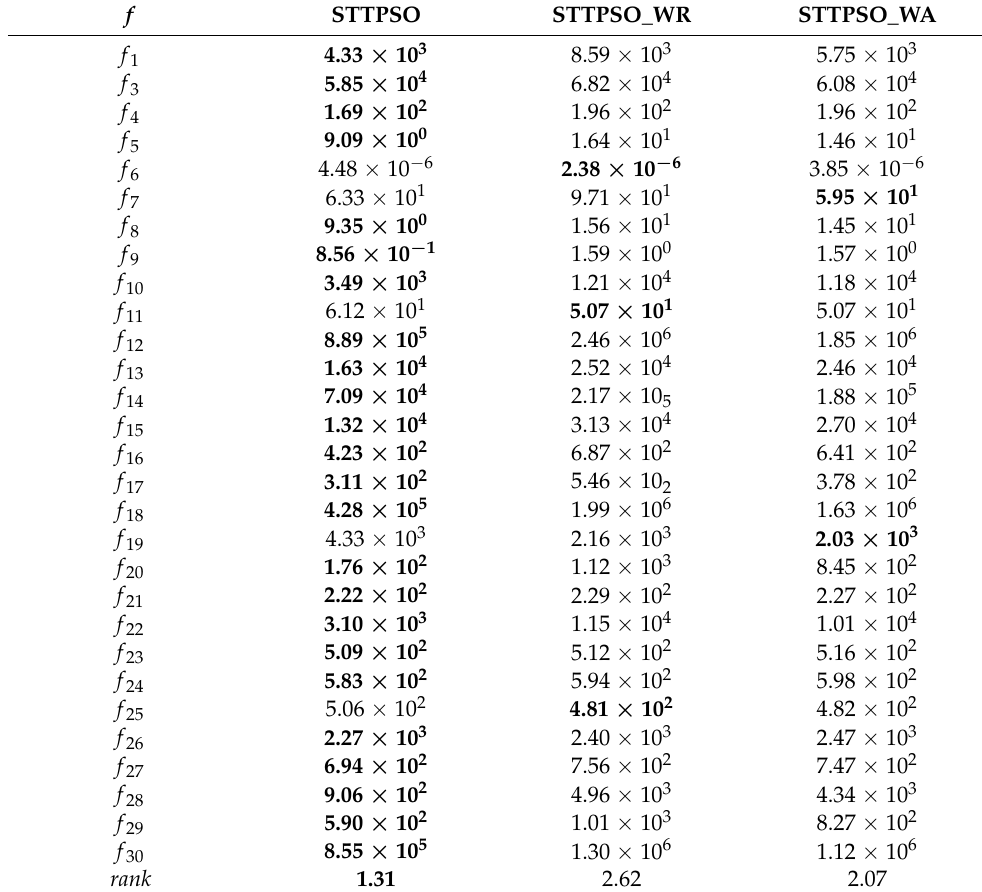
Table 8. Comparison results between STTPSO with and without the archive and the restart strategy on the 50- D CEC 2017 functions. The best results are highlighted in